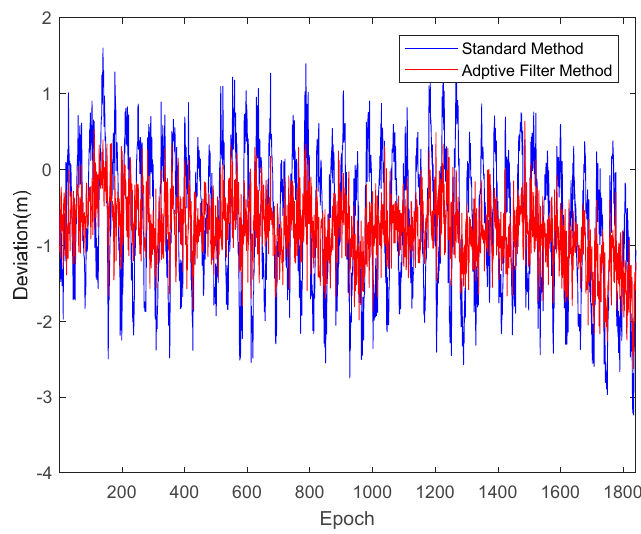
Figure 21. Pseudorange residuals comparison before and after frequency spectrum smoothing (R20, 1800 s).